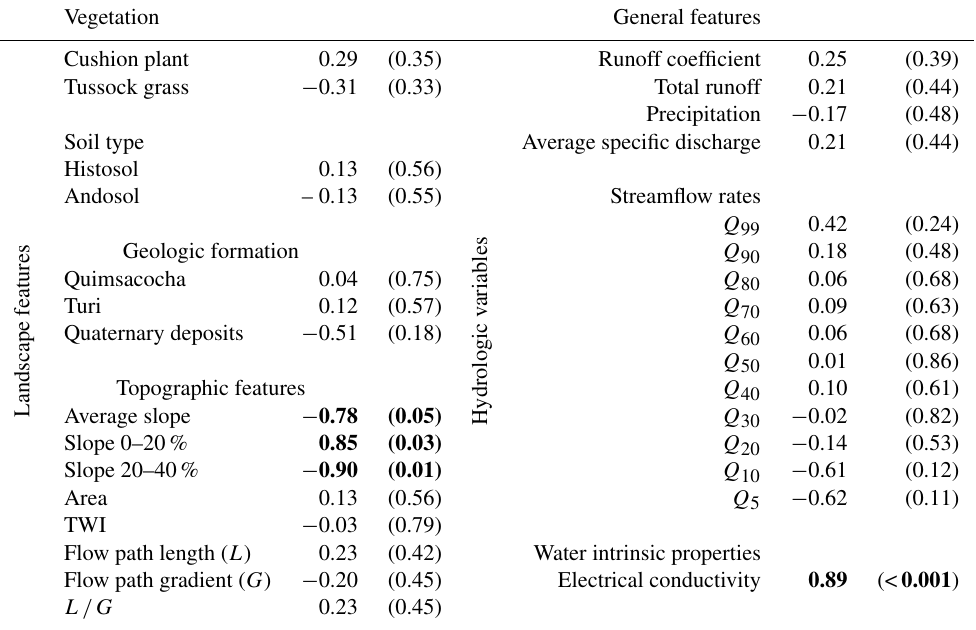
Signs indicate positive (no sign) or negative ( − ) correlation between parameters. Values in bold are statistically significant to a 95% level of confidence ( p <0.05). Values in parentheses are the p values of the correlations. ∗ TWI: topographic wetness index (Beven and